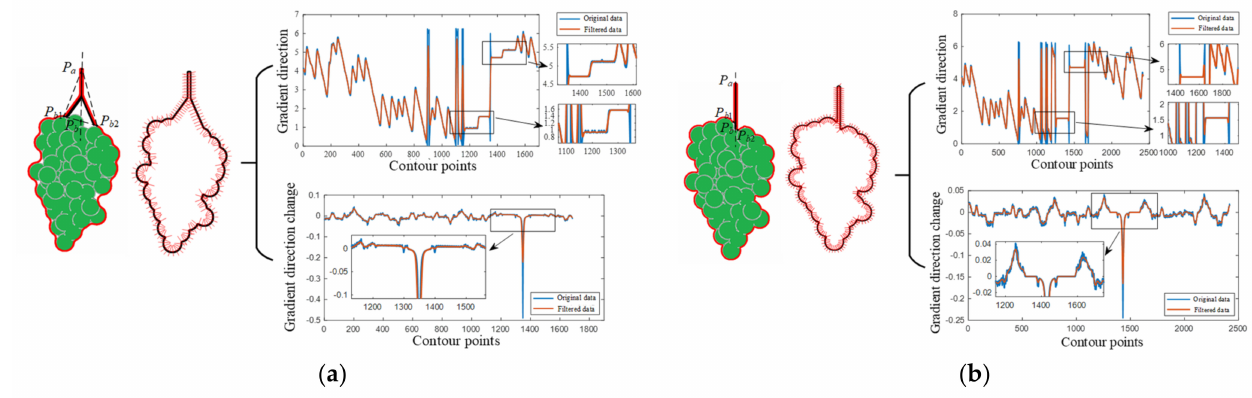
Figure 5. Gradient directions of fruit cluster contours. ( a ) Stalk with node; ( b ) stalk without node. The stalk contours are removed based on p b 1 and p b 2 . The constraints for detecting segmentation points of the cluster regions are constructed according to the global direction changes of contours, fitted ellipses of local contours, and gradient directions, as shown in Figure 6. The extremum of the global direction change curve of a fruit cluster contour mainly corresponds to the contour intersections of the stalk and cluster and the bottom contour of cluster. Compared with fruit cluster contour, the contour global directions of different clusters are different, and the direction changes in the intersections of the cluster contours are obvious. Therefore, the candidate positions of cluster segmentation points can be extracted according to the extremums of global direction change curves of cluster contours. The candidate positions include the intersections of different cluster contours, the bottom contours of clusters, and the berry contours on the cluster edges. Compared with the intersections of the different cluster contours, the centers of the fitting circles of the berry contours on the edges of the clusters are inside the cluster contours. Because the shape of the berry is not a standard circle and the cluster contour is composed of berry contours, there is a difference between the center position of the fitting circle of the berry contour on the cluster contour and the actual center position. Therefore, the centers of the arcs corresponding to the berry contours on the cluster contour are calculated based on ellipse fitting. The relationships between the fitted ellipse centers of the arcs corresponding to the candidate positions and cluster contour are judged to purify the candidate